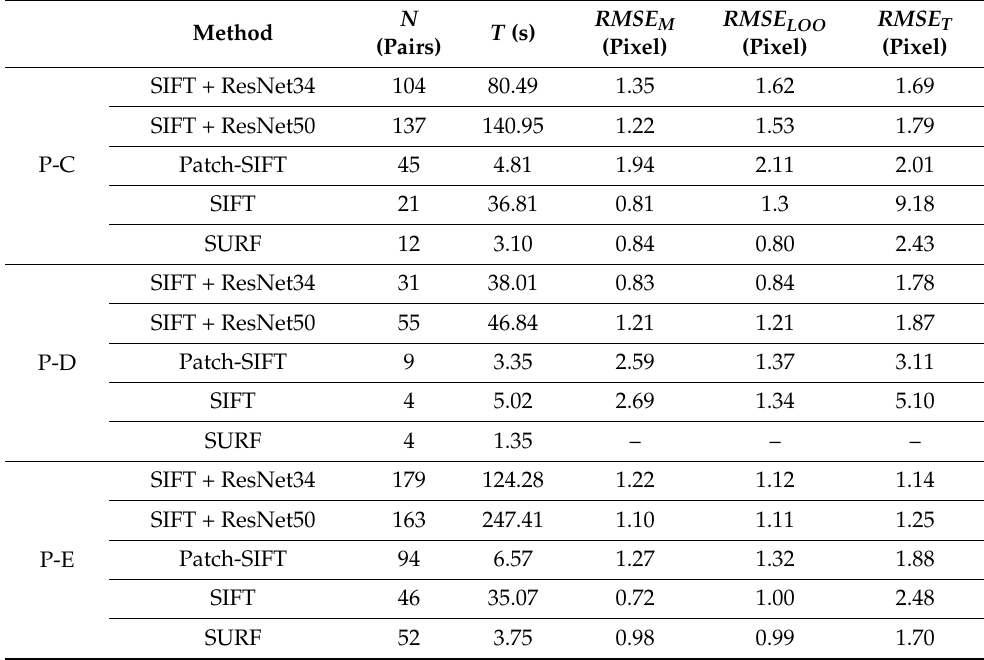
Table 5. Experimental results for HR multispectral images with disaster